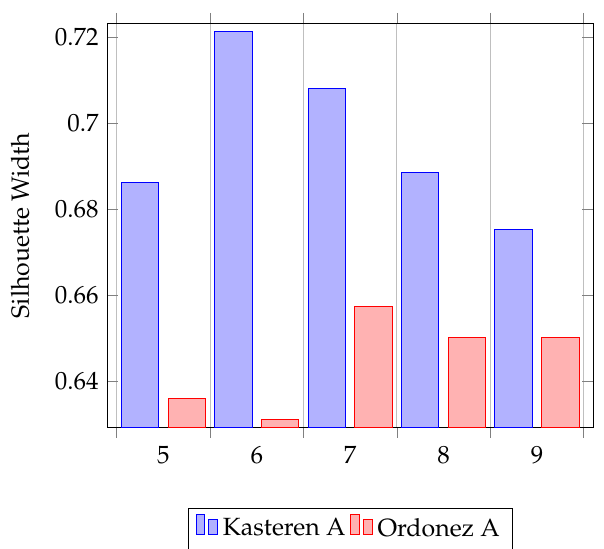
Figure 5. Silhouette width results for the Kasteren A and Ordonez A datasets indicative of the activity topics for the houses Table 6. Activity concepts and the discovered context descriptors for Kasterens House A. Activities